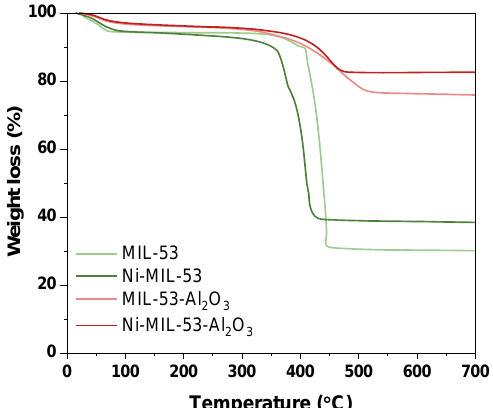
Figure 4. Thermal stability of MIL-53-based samples (TGA profiles).